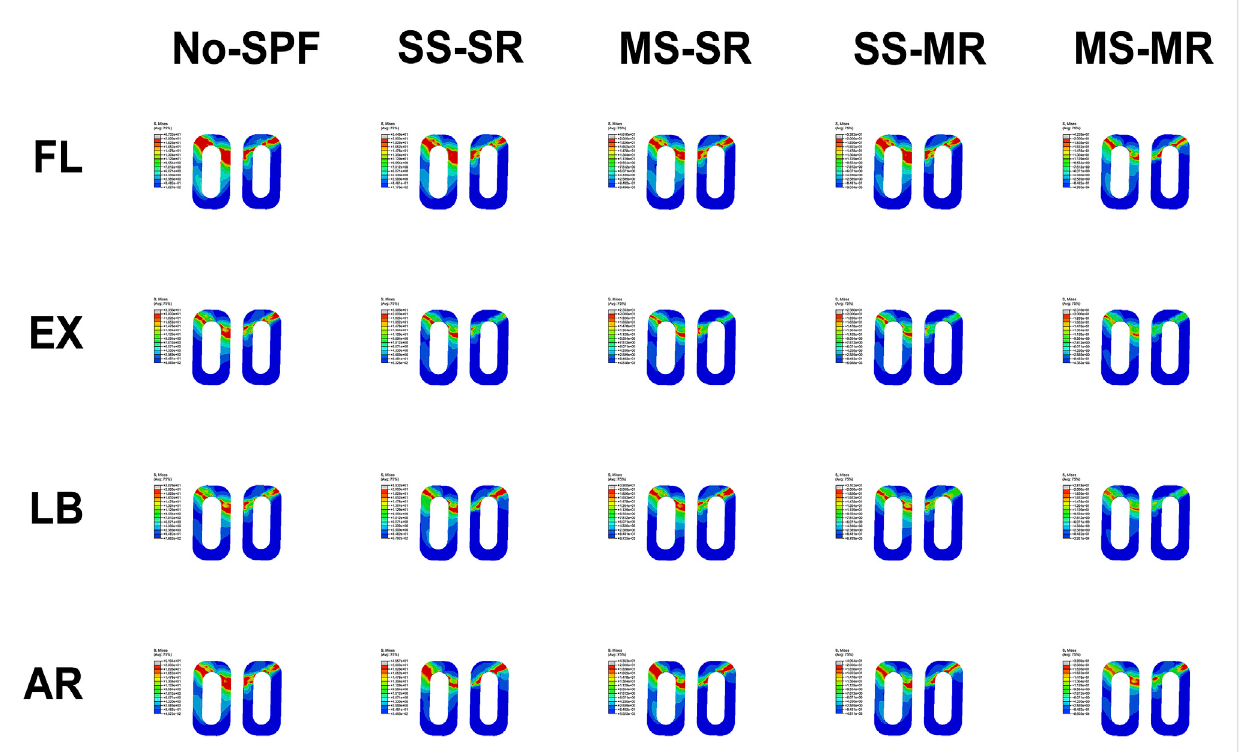
FIGURE 7 Von-Mises stress on cages of different instrumented models in fl exion, extension, lateral bending, and axial